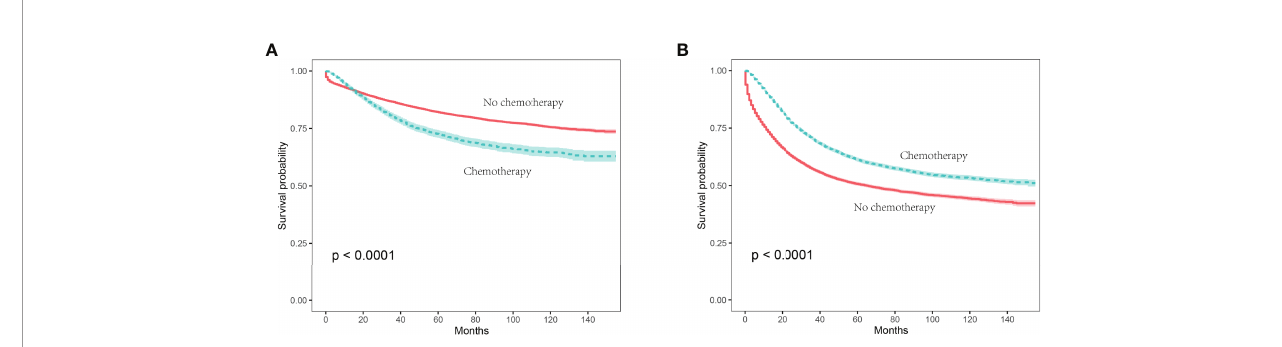
FIGURE 2 | Kaplan-Meier survival curves were plotted to calculate the CSS rate, and comparisons of survival difference between chemotherapy and no chemotherapy subgroups were performed using the log-rank test. (A) In stage II colon cancer patients, the 5-year CSS rates of no chemotherapy and chemotherapy groups were 82.0% and 72.4%, respectively (P < 0.001); (B) in stage III colon cancer patients aged 70 years or older, the 5-year CSS rates of no chemotherapy and chemotherapy groups were 50.7% and 61.3%, respectively (P <